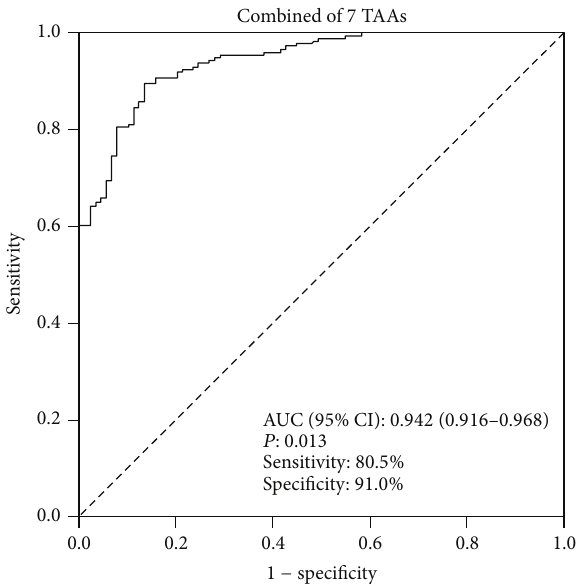
Figure 4: Sensitivity and specificity of ELISA based on combined seven TAAs (cyclin B1, survivin, p53, RalA, DFS70/LEDGFp75, MDM2, and NPM1) for differentiating between PCa ( 𝑛 = 174 ) and normal controls ( 𝑛 = 89